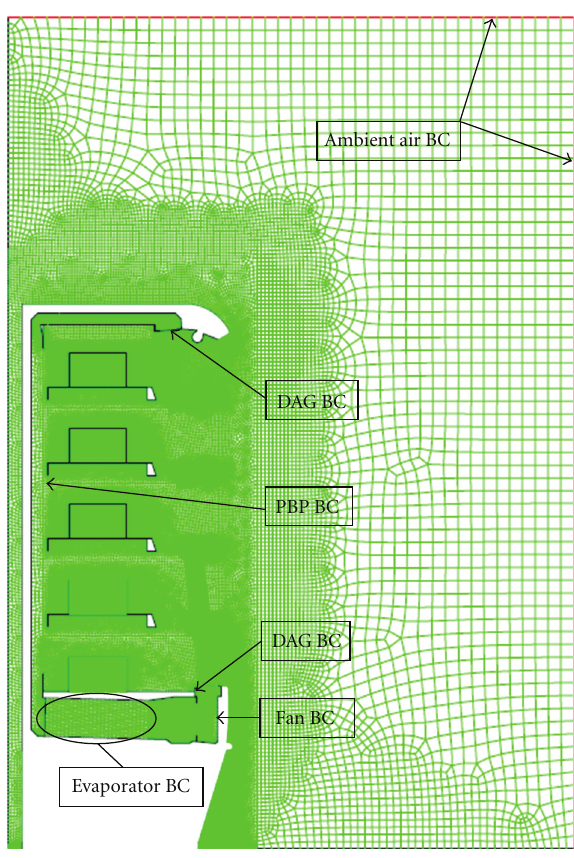
Figure 2: Computational model geometry and grid, and boundary conditions location.